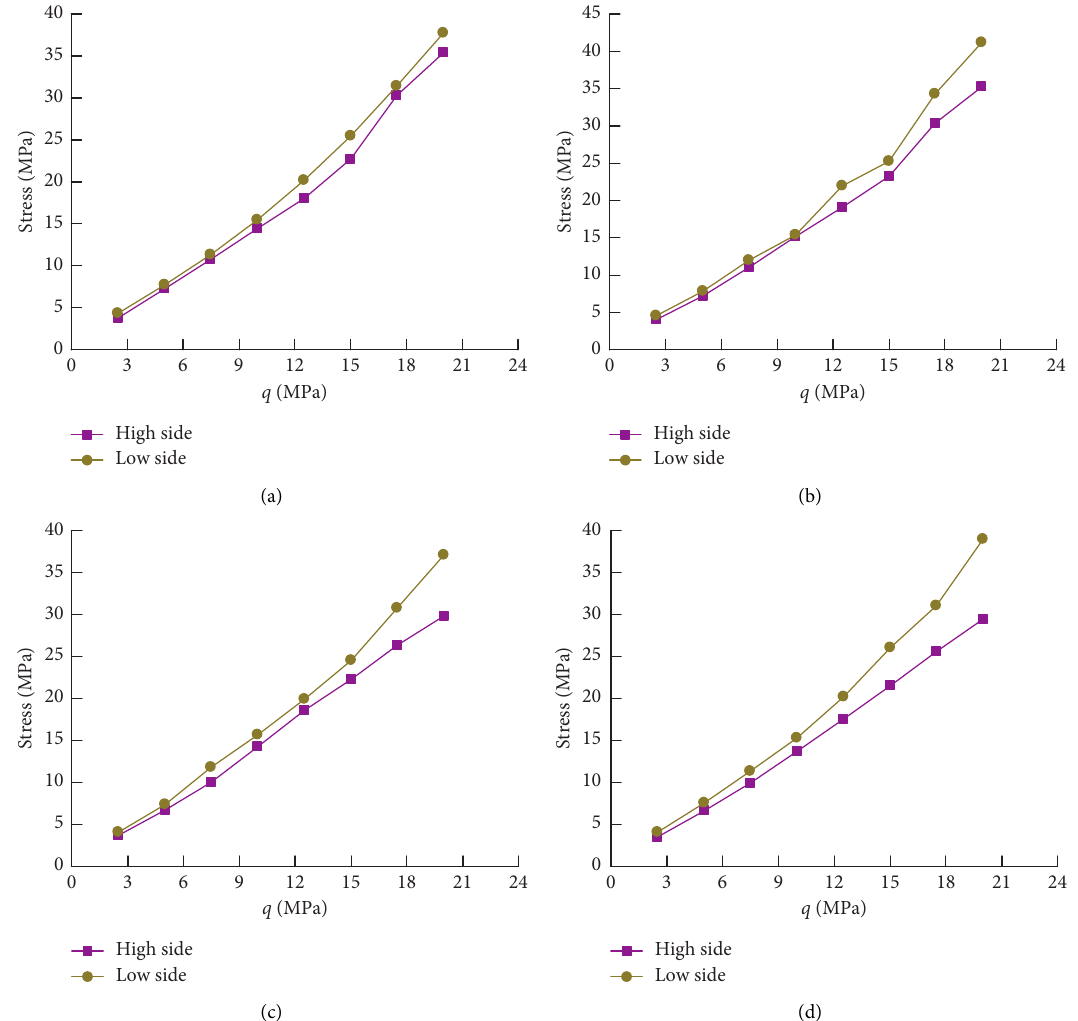
Figure 6: Comparative analysis curves of peak stress and ground stress of the two sides of the roadway. (a) 18 ° . (b) 21 ° . (c) 24 ° . (d) 27 ° .